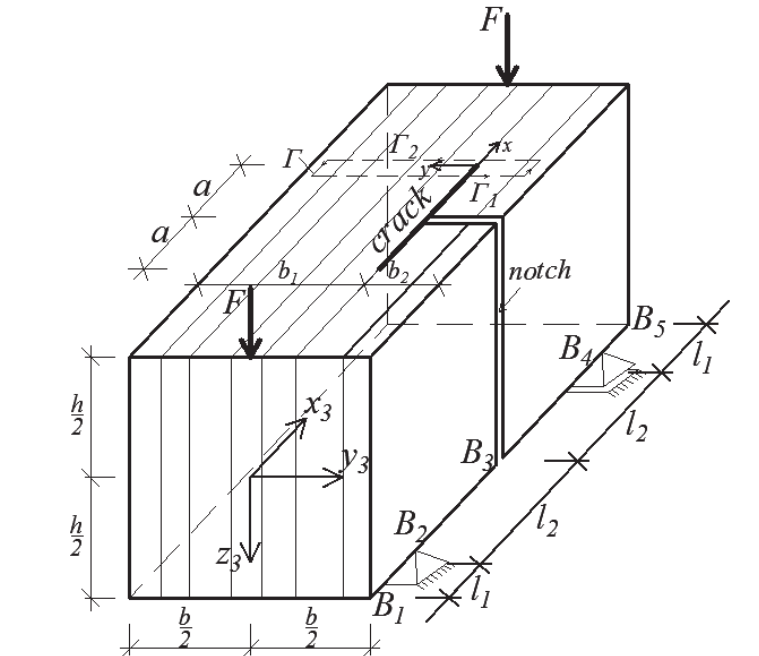
Figure 1: Loading and geometry of the multilayered four-point bending beam